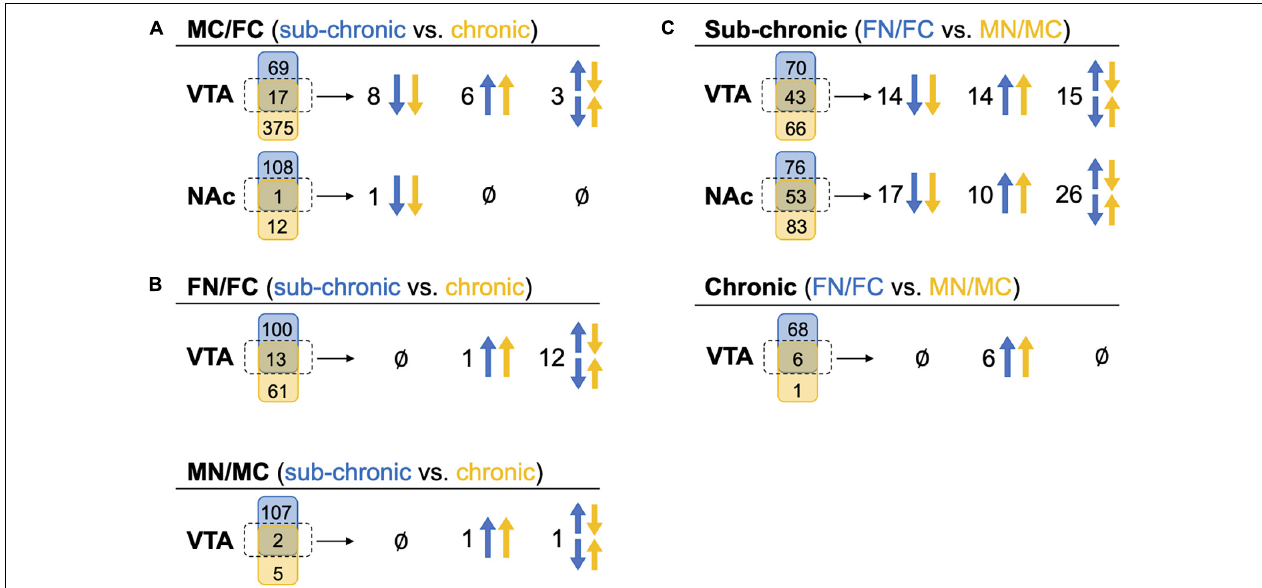
FIGURE 4 | Comparison of commonly altered proteins across sex and treatment groups. Headings indicate the pairwise tests being compared, while in parentheses the blue and yellow text indicate the groups from which those pairwise tests are being drawn for comparison. Under each heading, a Venn diagram for each brain region shows the numbers of proteins that were uniquely (blue or yellow shape) or commonly (middle green shape) identified as significantly altered proteins in these comparisons. The commonly altered proteins, outlined in a dotted line, are further delineated to be commonly up-regulated in both pairwise tests across blue and yellow groups (both arrows up), commonly down-regulated (both arrows down), or commonly identified but altered in different directions (set of arrows in opposite directions). (A) Significantly altered proteins in MC vs. FC for each brain region compared across the C3H/HeJ and C57BL/6J mice used for the sub-chronic and chronic nicotine administration groups, respectively. (B) Significantly altered proteins after nicotine vs. control treatment in each sex compared across nicotine administration groups. NAc is not shown because there were no commonly altered proteins across nicotine administration groups. (C) Significantly altered proteins after sub-chronic or chronic nicotine administration compared across